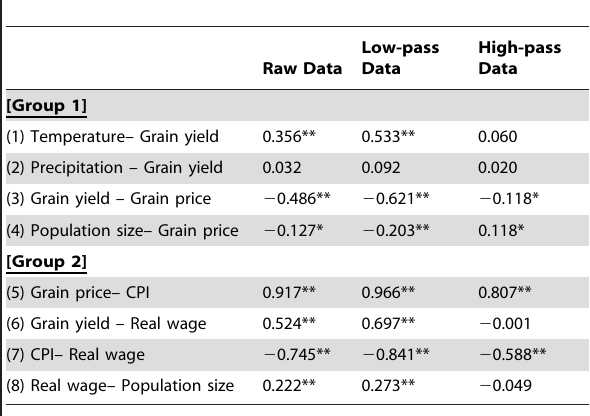
Table 1. Correlation Analysis Results of Causal Linkages in Figure 1.